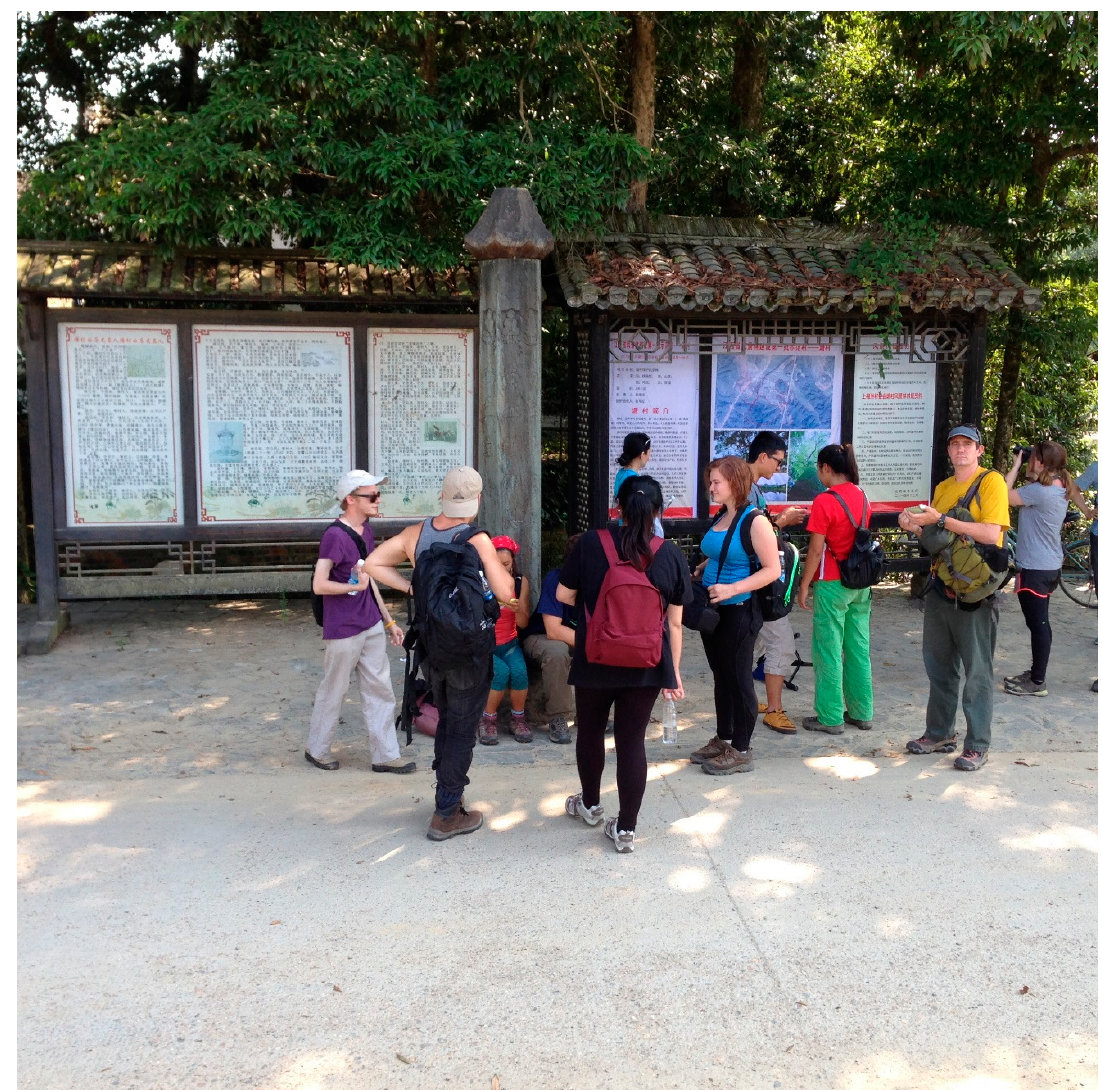
Figure 10. Students at the entrance to Tangcun Village, Jiangxi, which is designated a “Model Fengjinglin (Scenic) Village” and an “Ecological Civilization Vanguard Demonstration Area.” Detailed information on village history and ecology is shown on kiosks. (Photo by the author,